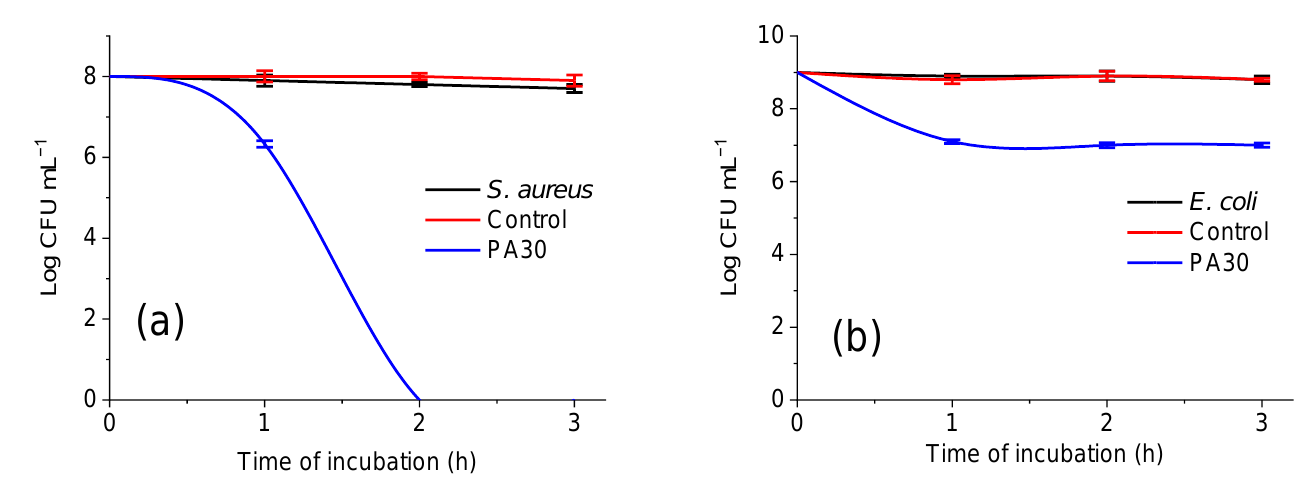
Figure 10. Time killing kinetics of S. aureus ( a ) and E. coli ( b ) in 0.3 mM KH 2 PO 4 with cotton fabric, and PA30.